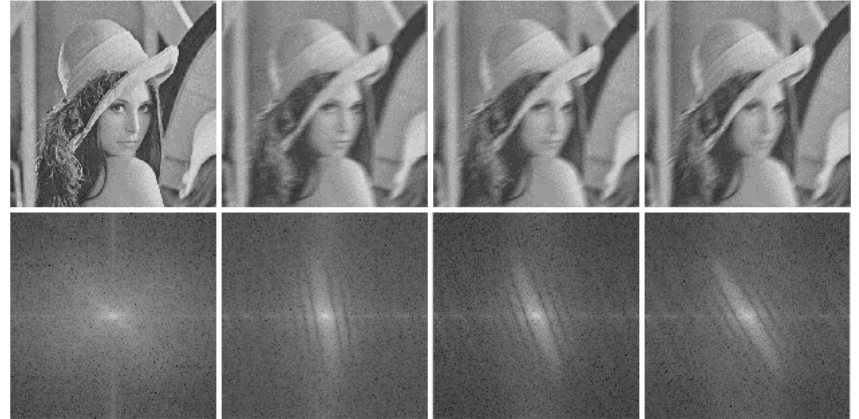
Figure 1. Figures from left to right are: original image with no motion, 20°, 40°, 60° movement in the horizontal direction. The figures blew are their corresponding spectrum.